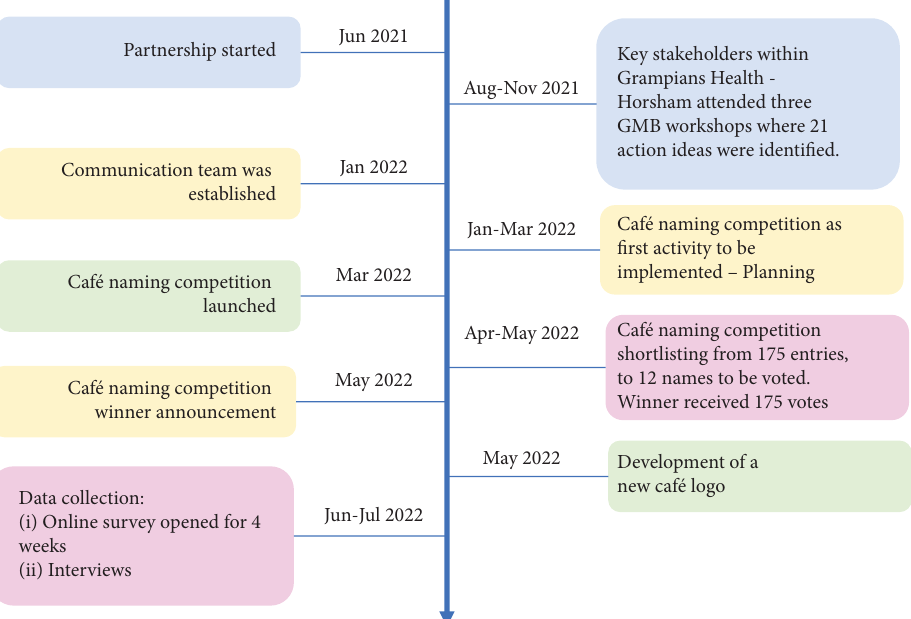
Figure 1: Naming competition activity